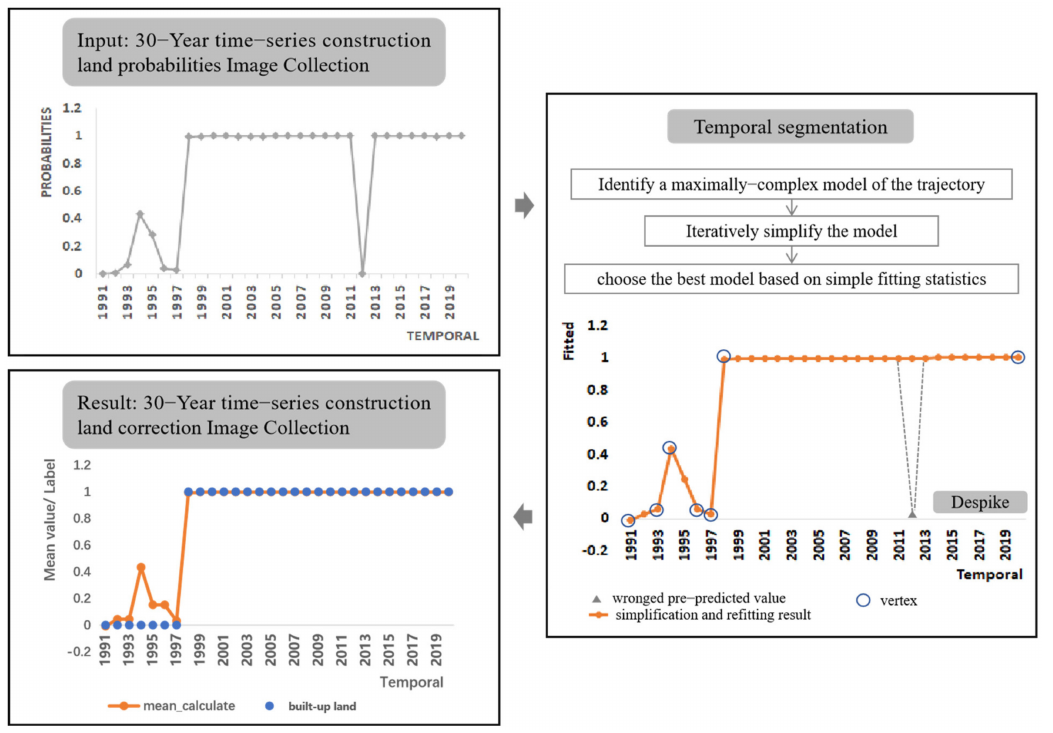
Figure 9. The procedure of pixel − based temporal